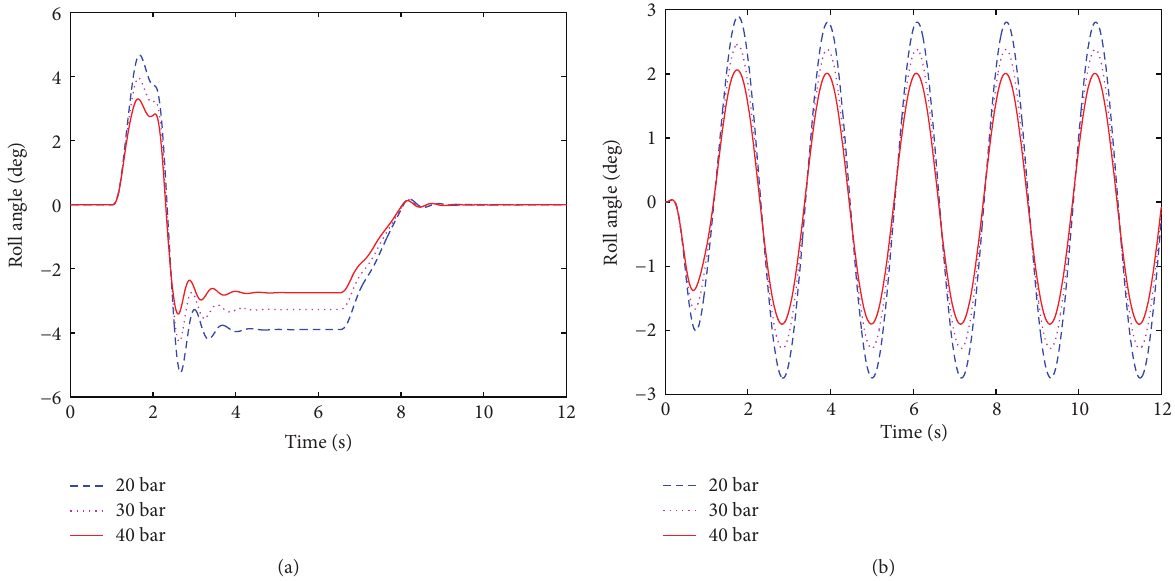
Figure 9: (a) Sprung mass roll angle of the VKDS with different oil pressures under the fishhook maneuver. (b) Sprung mass roll angle of the VKDS with different oil pressures under the slalom